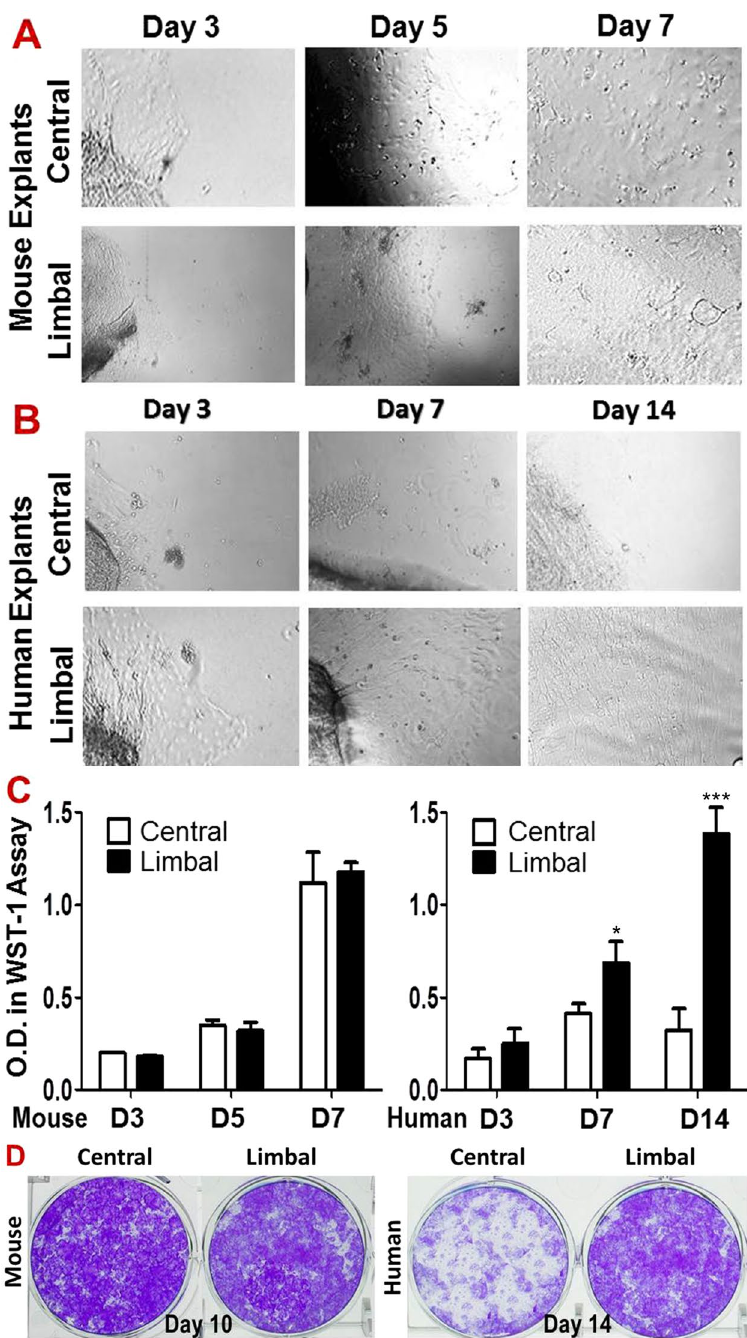
Figure 4. Comparison of proliferative capacity in primary corneal epithelial cultures between limbal and central cornea in mouse and human. ( A ) Phase-contrast microscopy showed the mouse epithelial cell growth of explants from limbal and central corneas on days 3, 5 and 7; ( B ) Human epithelial cell growth of explants from limbal and central corneas on days 3, 7 and 14. ( C ) WST-1 assay showed no difference of epithelial cell growth between limbal and central corneal explants from mice during 7 days (n = 5, P > 0.05); but there is growth difference between limbal and central corneal explants of human during 14 days. Data were summarized from 5 separated experiments. * P < 0.05 and *** P < 0.001 , as two groups compared. ( D ) The representative images from clonogenic assays of the single cells from corneal or limbal epithelia in mice and